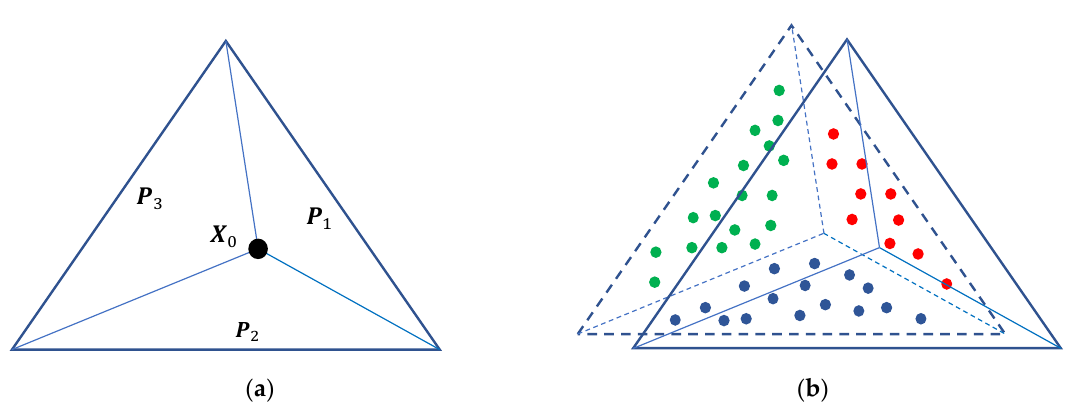
Figure 3. Lidar 3D absolute error based on three-plane intersection using least square regression. ( a ) Three-plane object from reference TLS data. ( b ) Airborne data with translational error only. The red, blue, and green dots are sampled points for planes 𝑷 1 , 𝑷 2 , 𝑷 3 , respectively.